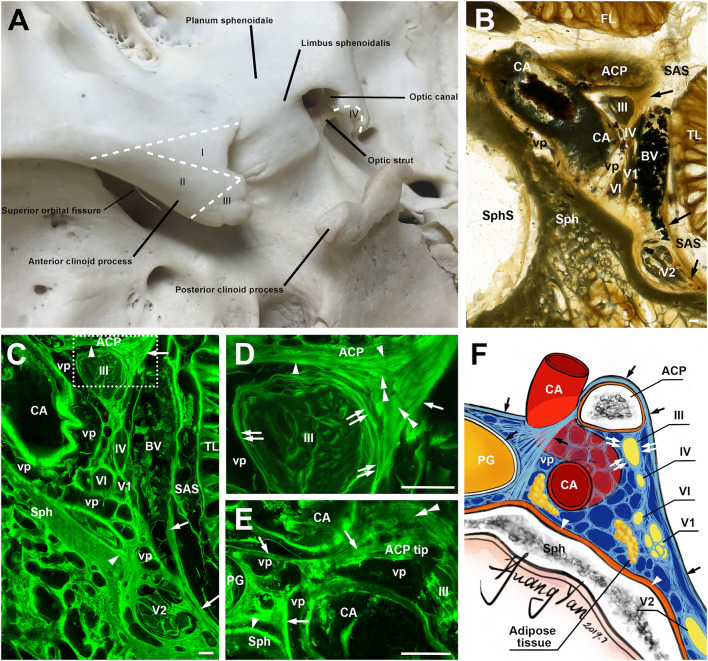
The anterior clinoid process (ACP) and its meningeal coverings. (A) A posterosuperior view of the ACP, showing its four zones (I–IV). (B) A coronal sheet plastination section at the level of the clinoidal segment of the carotid artery (CA). Arrows point the lateral wall of cavernous sinus. (C) is the mirror confocal image of (B). Arrowheads point to the periosteal dura. Arrows point to the meningeal dura. (D) is the higher magnification of the dashed line box of (C), showing the meningeal architecture (single arrow and arrowheads) on the inferolateral surface of the ACP and its relationship with the dural sleeves (double arrows) of the ocular motor (III) and the lateral wall of the cavernous sinus. Double arrowheads point to sagittally orientated meningeal dural fibers, which originated from the tentorium and inserted to the ACP. (E) is from an adjacent section through the tip of the ACP, 3.4 mm posterior to (D), showing the meningeal dural fibrous bundles (arrows) between C4 and C6 segments of the CA. (F) An illustration showing the meningeal architecture of the ACP and its surrounding structures that were mentioned in the previous images. BV, cerebral bridging vein; vp, venous plexus; Sph, sphenoid bone; SphS, sphenoid sinus; TL, temporal lobe; FL, frontal lobe; SAS, subarachnoid space; cranial nerves II, III, IV, V1, V2, and VI; bars = 1 mm.